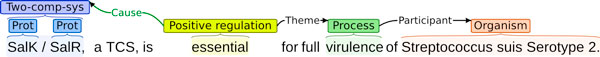
Example ID event annotation. The association of a TCS with an organism is captured through an event structure involving a PROCESS ("virulence") and POSITIVE REGULATION. Regulation types are used to capture also statements of general causality such as "is essential for" here. (Simplified from PMC ID 2358977).